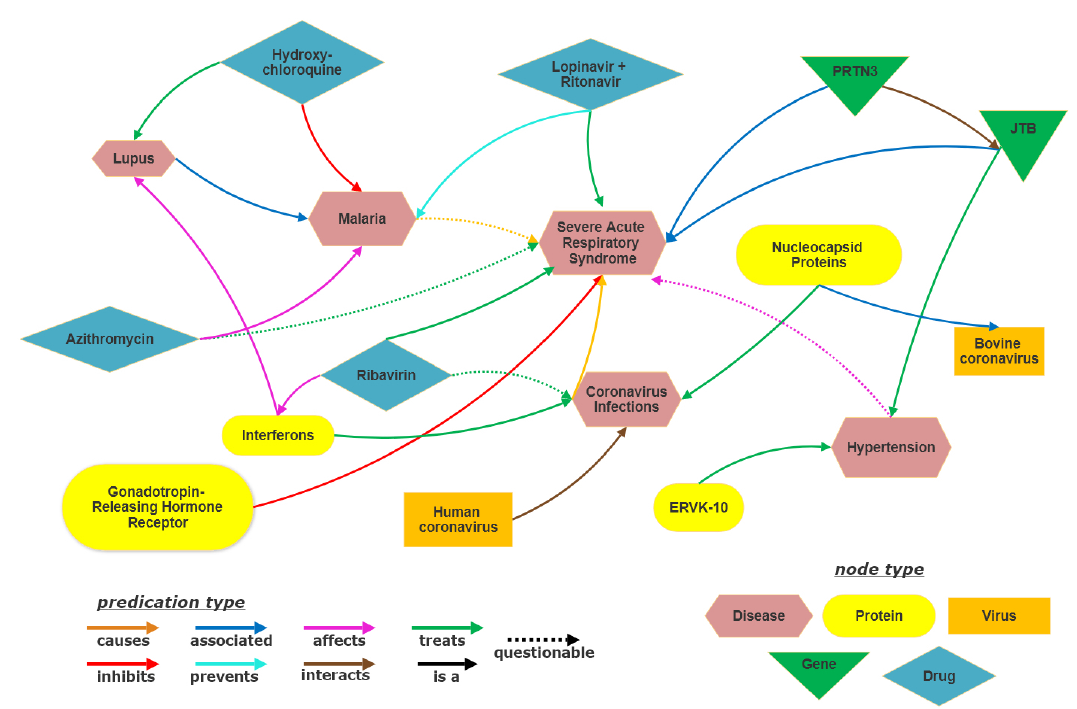
Figure 1. Visualization of subgraph of SemNet Knowledge graph.